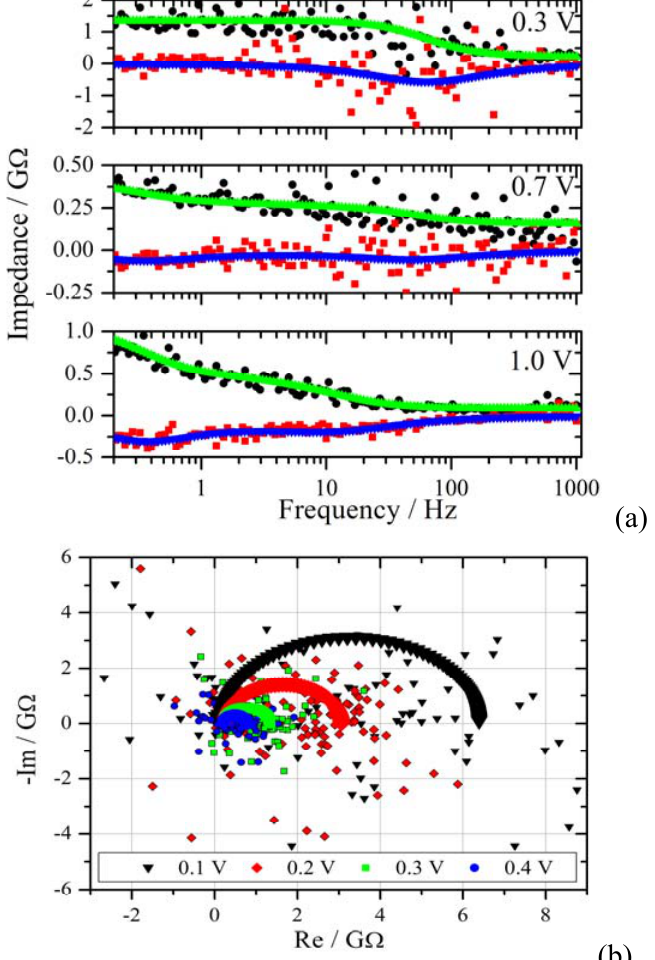
Figure 6. ( a ): Bode plot of the impedance spectra from the measurements of Figure 4 with a voltage step from zero to 0.3 V, 0.7 V and 1.0 V. The upper curves are the fits of the real part to the experimental data (black dots), the lower curves and red squares represent the imaginary part. Note the different Y-scales for the impedance; ( b ): Nyquist diagram of the experimental and the simulated impedance spectra for the voltage steps given in the